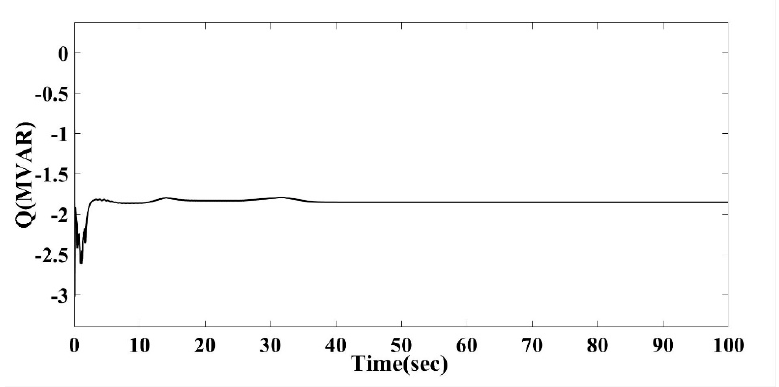
Figure 22. Reactive power with QL.